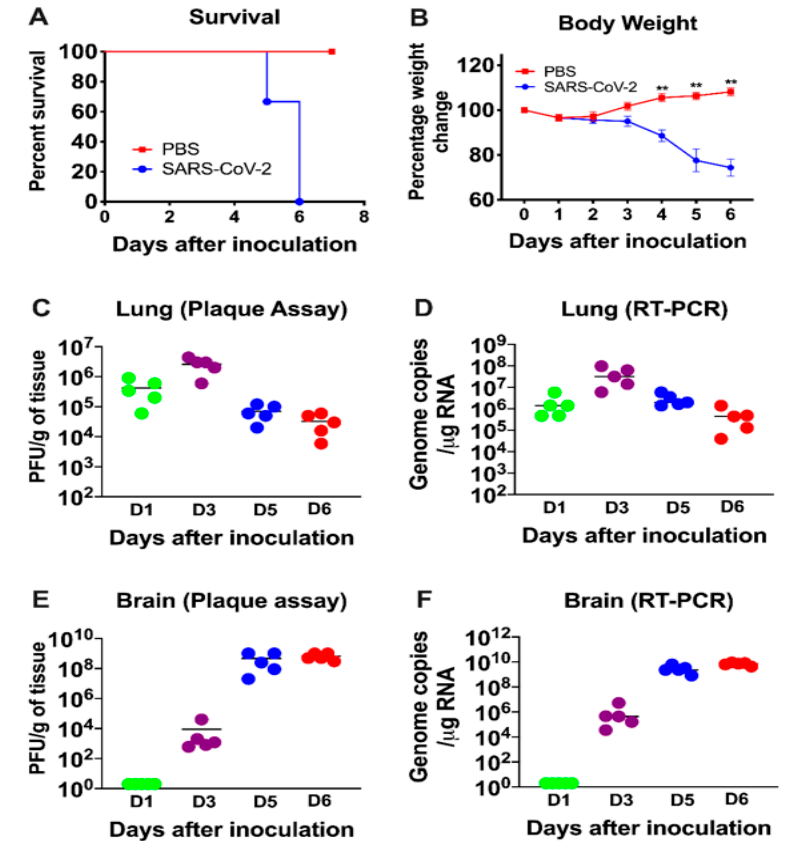
Figure 1. Analysis of survival, body weight and virus titers in K18-hACE2 mice following SARS-CoV-2 infection. K18-hACE2 mice were inoculated intranasally with SARS-CoV-2 (10 5 plaque-forming units (PFU), ( n = 20) or PBS (Mock, n = 10). ( A ) Percentage of survival was determined. ( B ) Percentage of daily body weight change in the animals. Error bars represent SEM. **, p < 0.001. The kinetics and levels of SARS-CoV-2 were determined in the lungs ( C and D ) and brain ( E and F ) by plaque assay and qRT-PCR. The data are expressed as PFU/g of tissue or genome copies/ μ g of RNA. Each data point represents an individual mouse. The solid horizontal lines signify the median value.